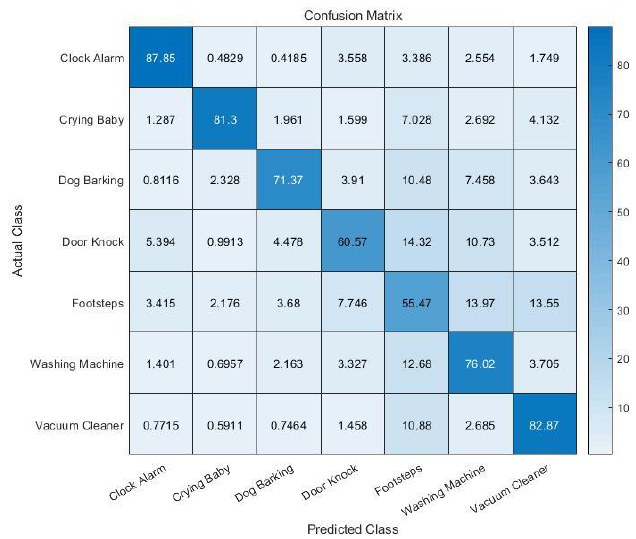
Figure 18. Five-fold cross-validation accuracy (MFCC only).